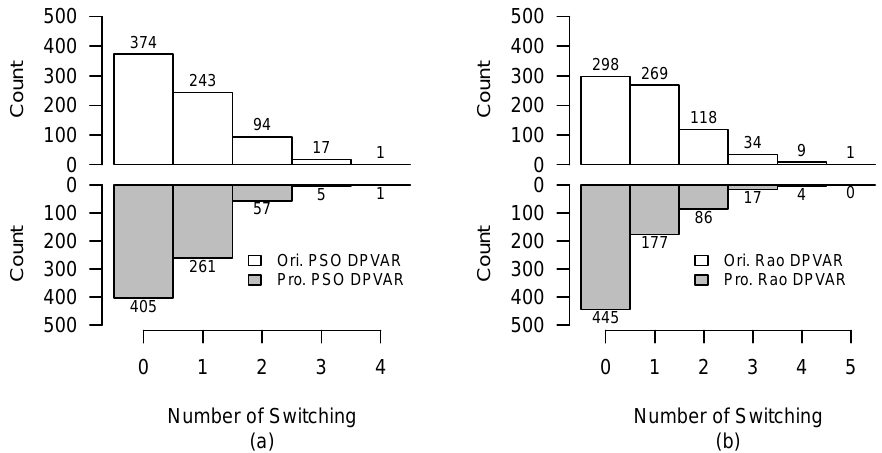
Figure 23. Comparison of switching operation of original-reconfigured and proposed-reconfigured PV arrays under Case 2 without lagged time. ( a ) PSO-reconfigured PV array. ( b ) Rao-reconfigured PV